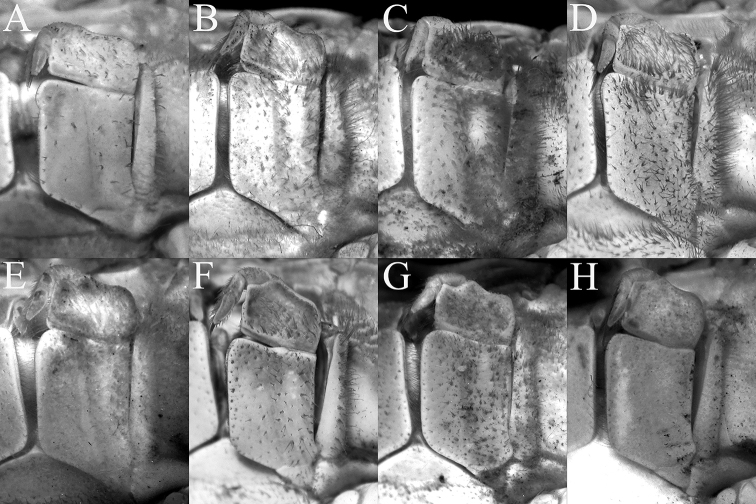
Left third maxilliped AJohora
intermedia Ng, 1986, holotype male (19.8 × 15.1 mm) (ZRC 1984.6529), Pahang BJ.
tahanensis (Bott, 1966), male (30.7 × 25.5 mm) (ZRC 1984.6795), Pahang CJ.
thoi Ng, 1990, holotype male (41.2 × 33.3 mm) (ZRC 1989.2249), Terengganu DJ.
hoiseni Ng & Takeda, 1992, holotype male (25.1 × 21.1 mm) (ZRC 1984.6673), Kelantan EJ.
thaiana Leelawathanagoon, Lheknim & Ng, 2005, paratype male (22.2 × 18.6 mm) (ZRC 2006.0052), Thailand FJ.
booliati sp. nov., holotype male (34.6 × 30.0 mm) (ZRC 2020.0072), Pahang GJ.
erici sp. nov., holotype male (38.3 × 32.0 mm) (ZRC 2020.0360), Perak HJ.
michaeli sp. nov., holotype male (22.7 × 19.2 mm) (ZRC 2010.0047), Terengganu.